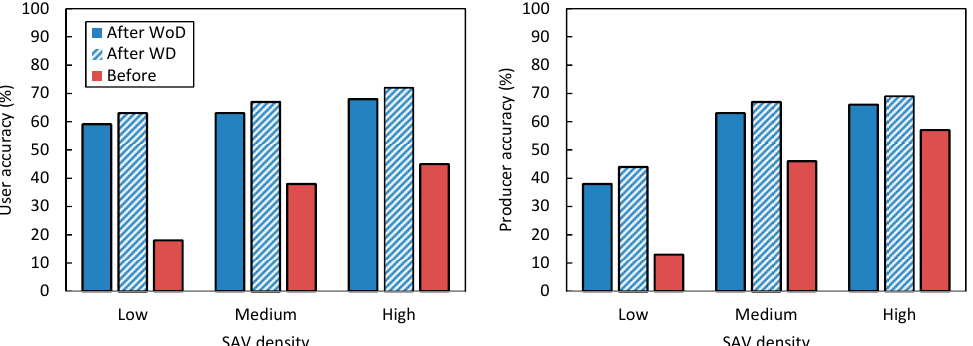
Figure 17. User and producer accuracies of SAV density clusters derived from WV3 image based on VI (RE, R) before and after water-column correction with (WD) and without (WoD) accounting for deep-water reflectance, R ∞ rs .